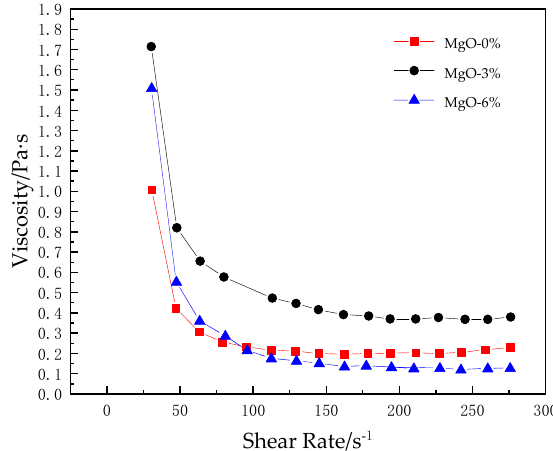
Figure 5. Shear viscosity as a function of shear rate.